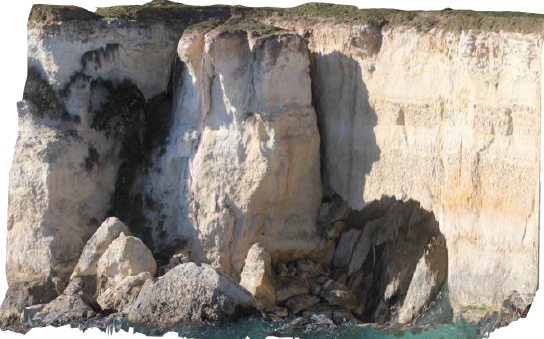
Figure 6. Detail of the tumbledown mass